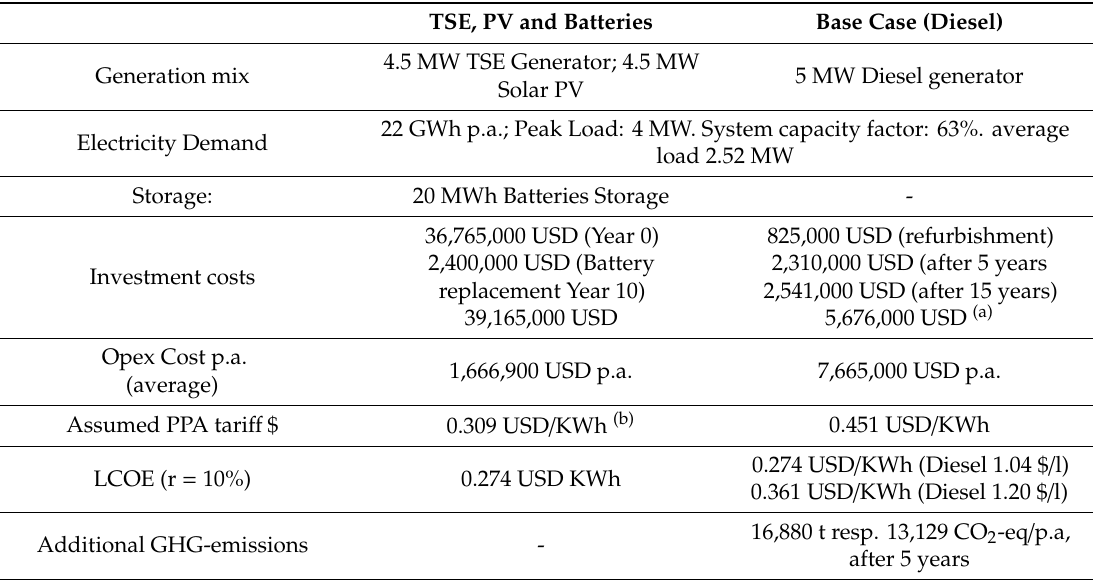
Table 1. Core values of base case and hybrid